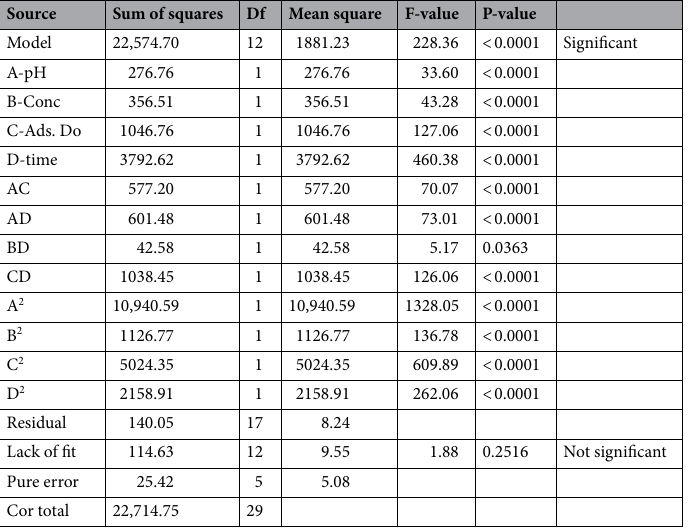
Table 2. ANOVA results for Pb(II)